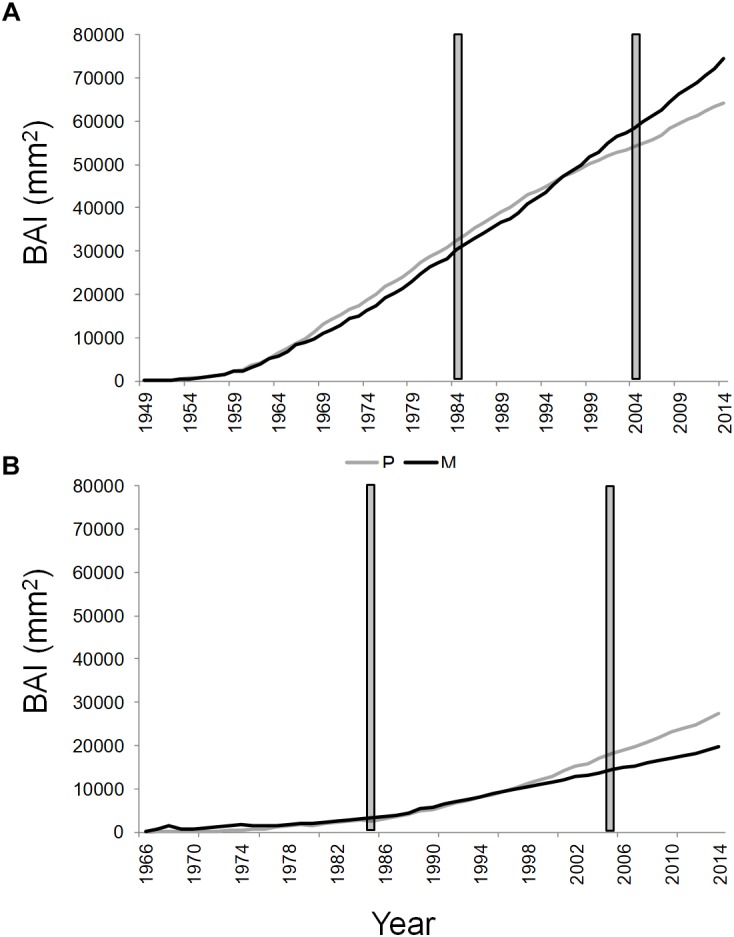
Cumulative basal area increment of Q. ilex growing in pure (in gray) and mixed (in black) stands, in the “Tirone Alto-Vesuvio” (A) and in the Mount Somma (B) sites. The gray bars delimit the period chosen for isotope and statistical analysis.